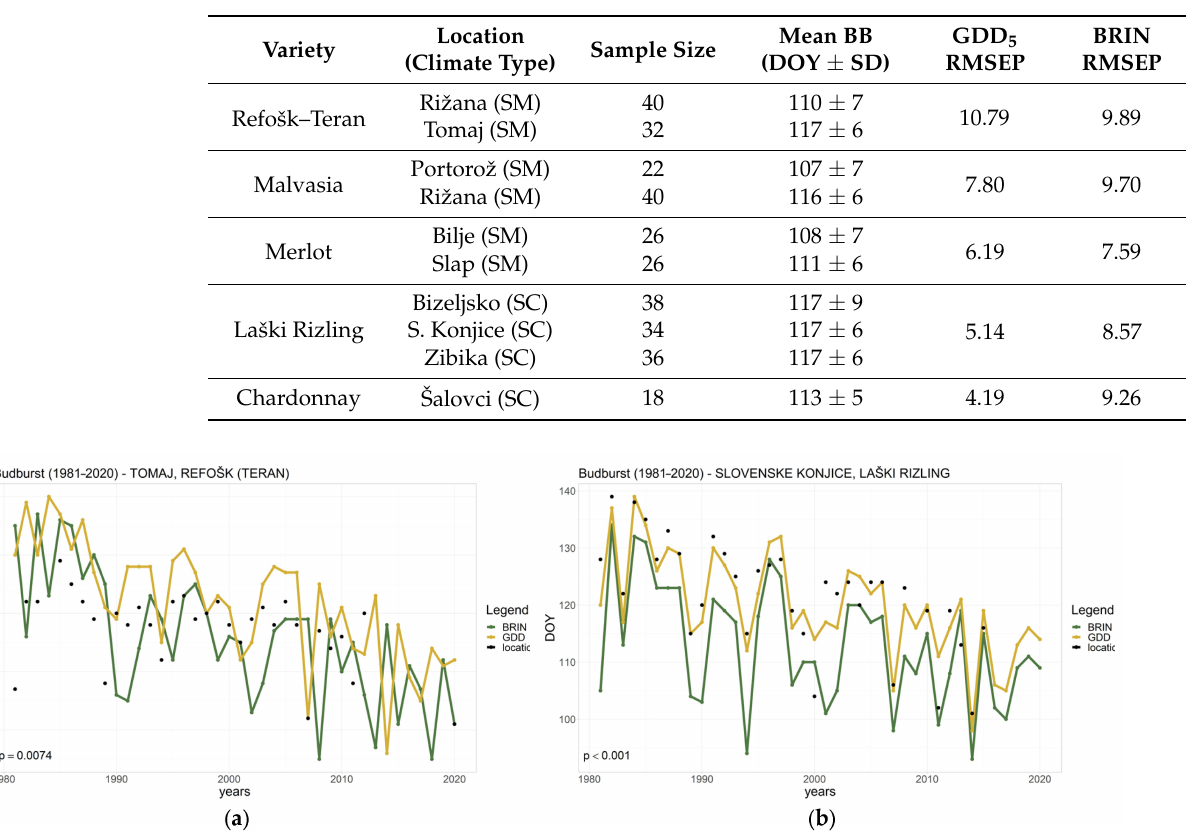
Table 2. Mean and standard deviation of observed historical budburst dates for the available sample sizes of several grapevine varieties, and the performance of GDD 5 and BRIN models in modeling budburst dates. The assessment was made by calculating the root mean square error of prediction (RMSEP) for the modeled and observed budburst dates. In both models, the base temperature is T b = 5 ◦ C.